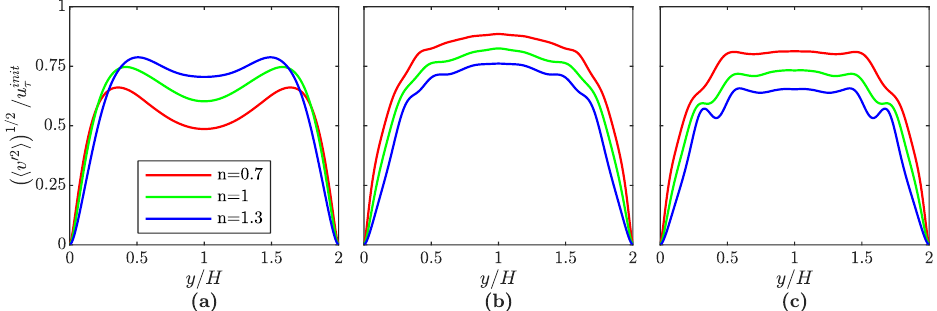
Figure 10. Root mean square of the wall-normal velocity fluctuations v (cid:48) , normalized by the friction velocity of the initialization setup, as a function of the wall-normal coordinate for the single-phase ( a ) and the two-phase setups with Eo = 0.3125 ( b ) and Eo = 3.75 ( c ).